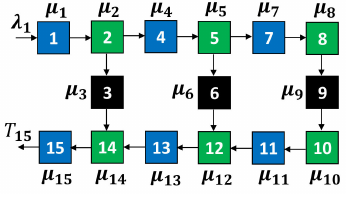
Figure 8. Small-scale topology. Table 2. Input parameters of experiment